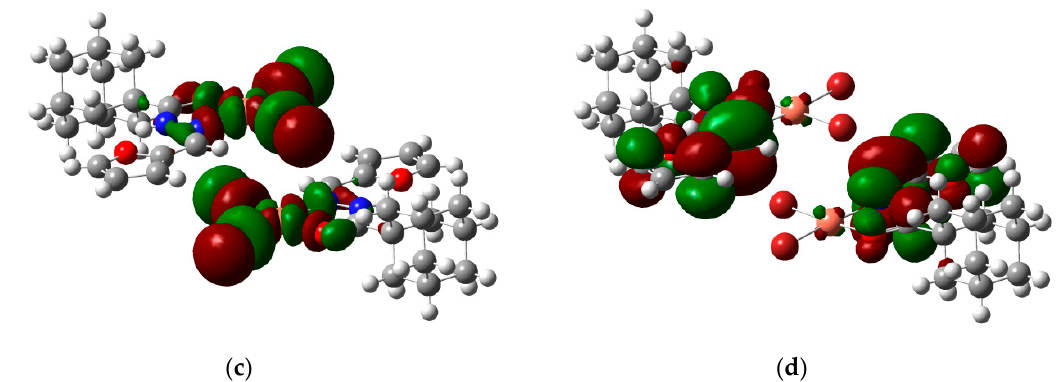
Figure 5. Presentation of the HOMO–LUMO in 1 obtained at 6-31G(d)/B3LYP of theory. ( a ) HOMO-1; ( b ) HOMO; ( c ) LUMO; ( d ) LUMO+1.